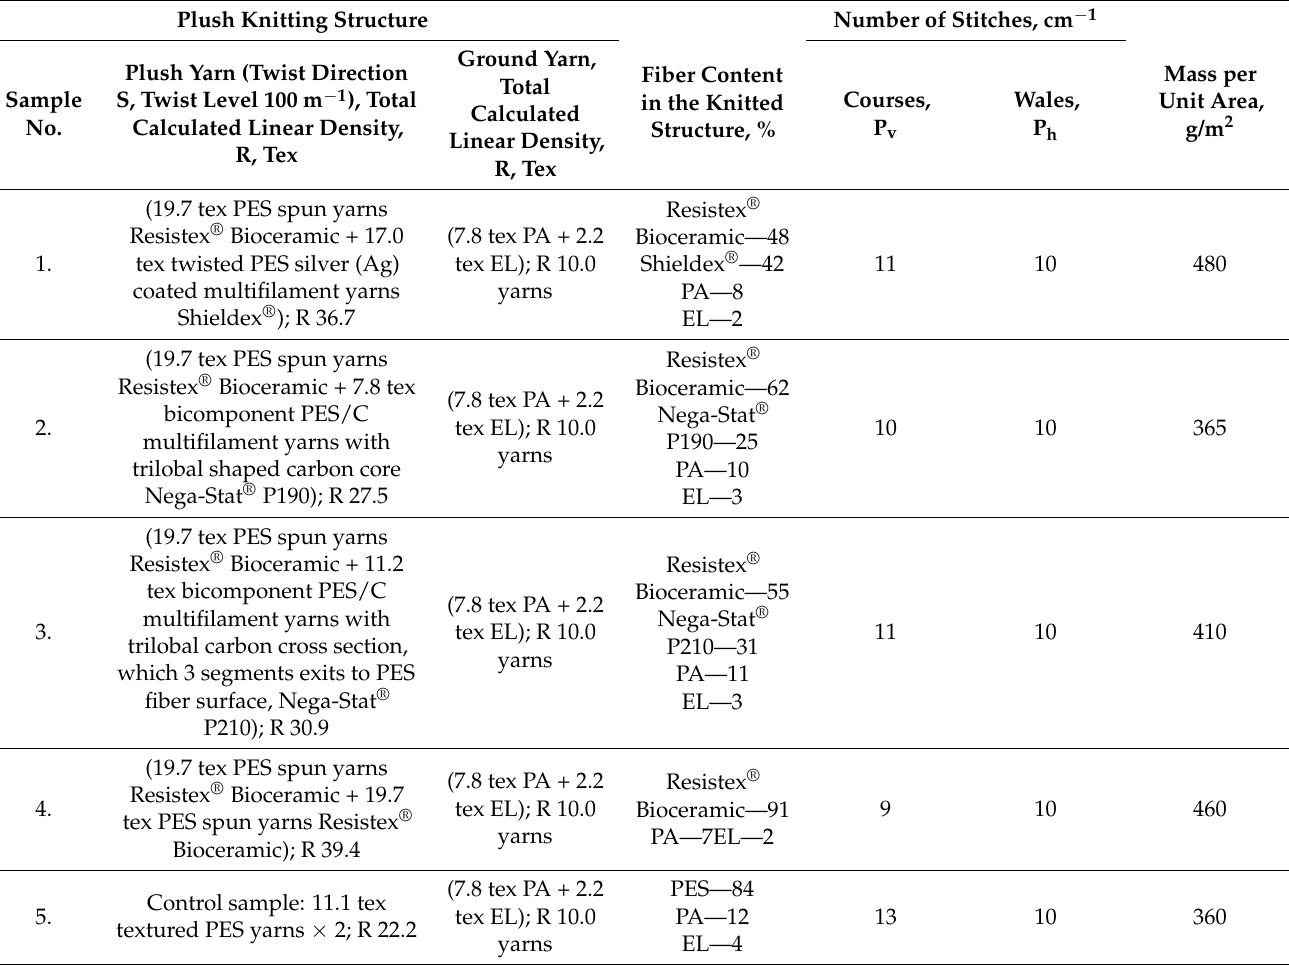
Table 2. Structure characteristics of the main parts of the